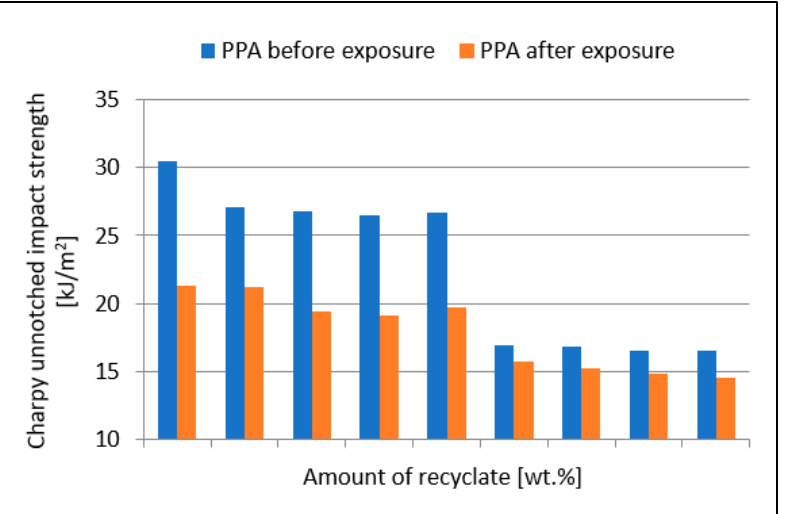
Figure 7. Dependence of the unnotched impact strength of PPA on the amount of recycled material before and after the samples were exposed to elevated temperature (+23 °C).